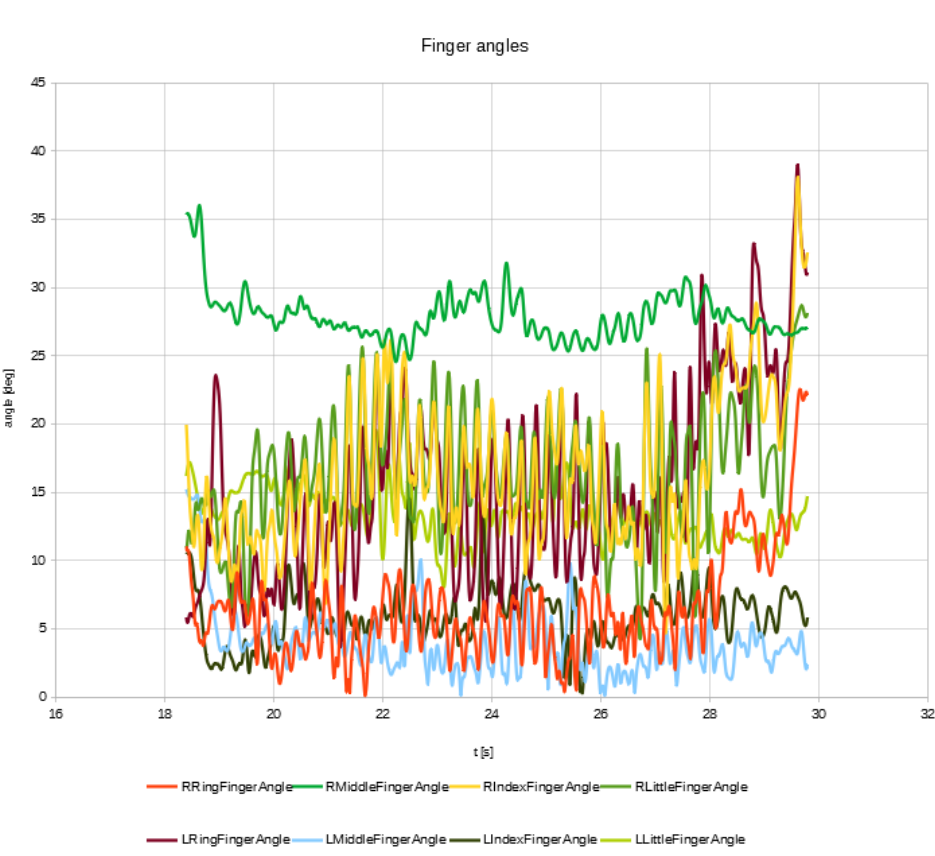
Figure 11. Angles for hands movement for the second